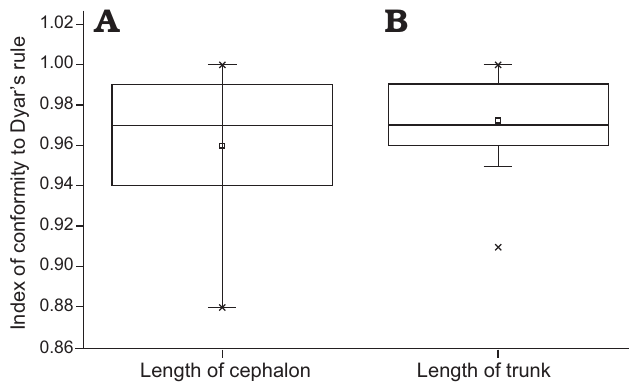
Fig. 12. Boxplot showing the relationship about the index of conformity to Dyar’s rule for the cephalic and trunk length of Changaspis elongata Lee in Chien, 1961. The middle line in the box, which is the median of the dataset, represents the average of the sample data. The width of the box partly reflects the volatility of the dataset. Above and below the box, there is a line, respectively represent the maximum and minimum